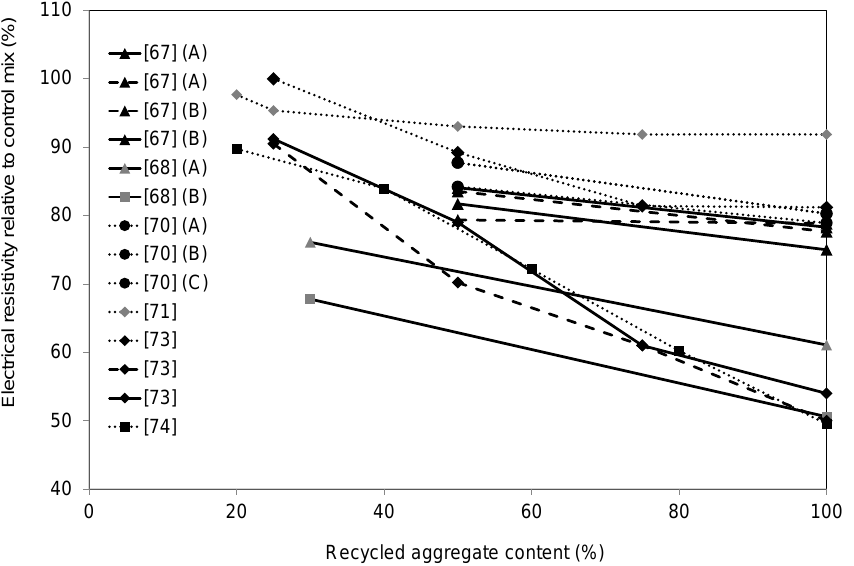
Figure 1. Effect of RAs on the electrical resistivity of concrete. Solid lines indicate the use of the fine and coarse RA together. Dotted lines indicate the use of coarse RA only. Dashed lines indicate the use of fine RA only.